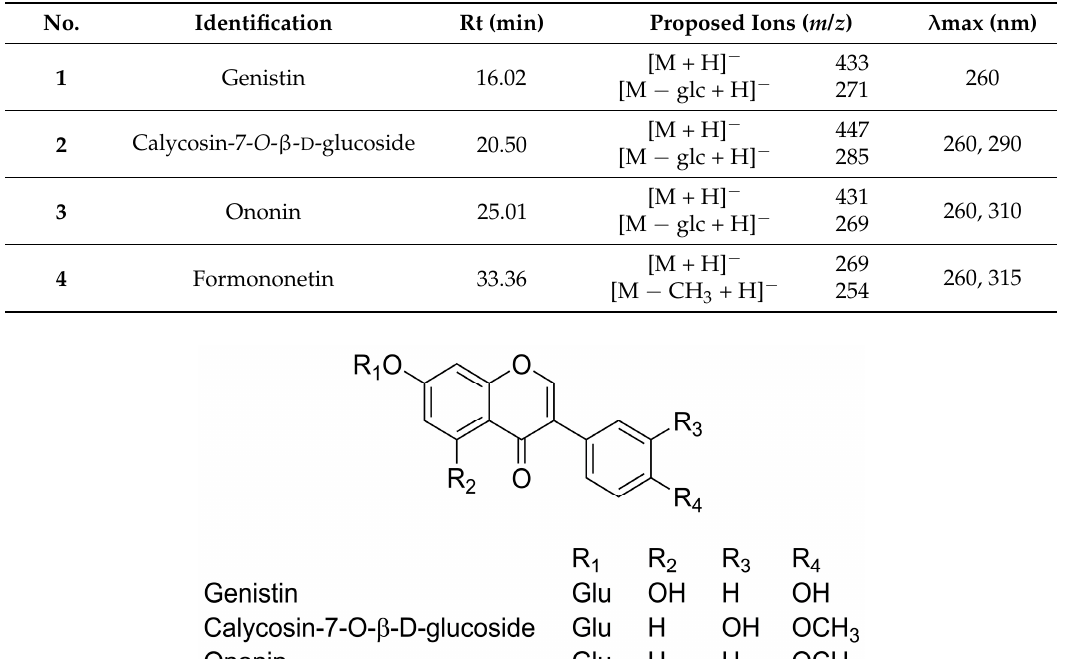
Table 1. The identification, retention time, UV and MS characteristics of compounds in Radix astragali extract.